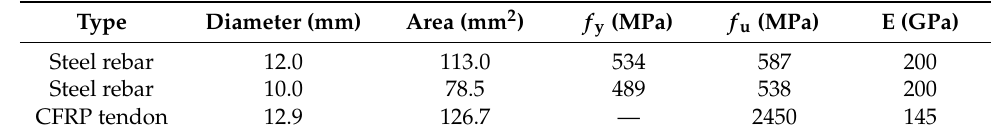
Table 1. Properties of material used in specimens C2 and C4.